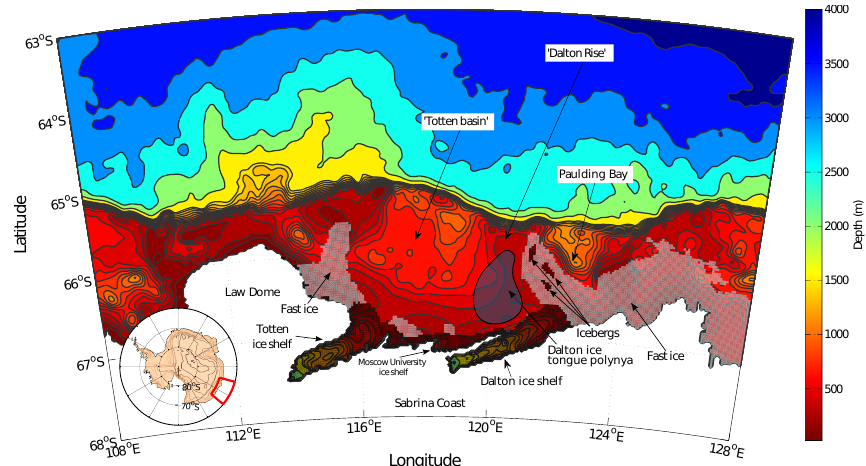
Fig. 1. Model bathymetry and domain. The contour interval is 100m up to 1500m depth and 500m up to 4000m depth. Ice shelves and icebergs (dark shading), fast ice (bright shading), polynya (mauve shading with dark outline) and major bathymetric features are indicated. Inset shows model domain location in